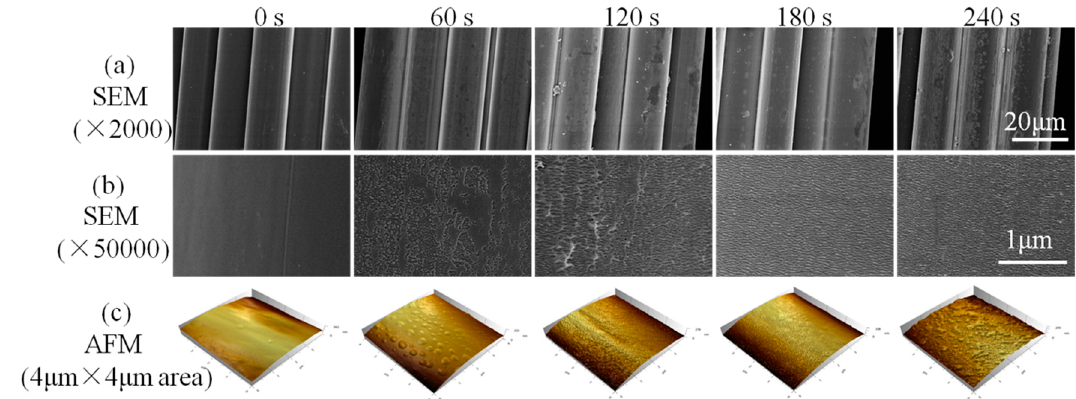
Figure 2. Surface morphologies of PI filaments with plasma treatment time of 0, 60, 120, 180 and 240 s, where ( a ) SEM images with 2000 magnification, ( b ) SEM images with 50,000 magnification and ( c ) 3D atomic force microscope (AFM) images with the scan size of 4 μ m × 4 μ m.